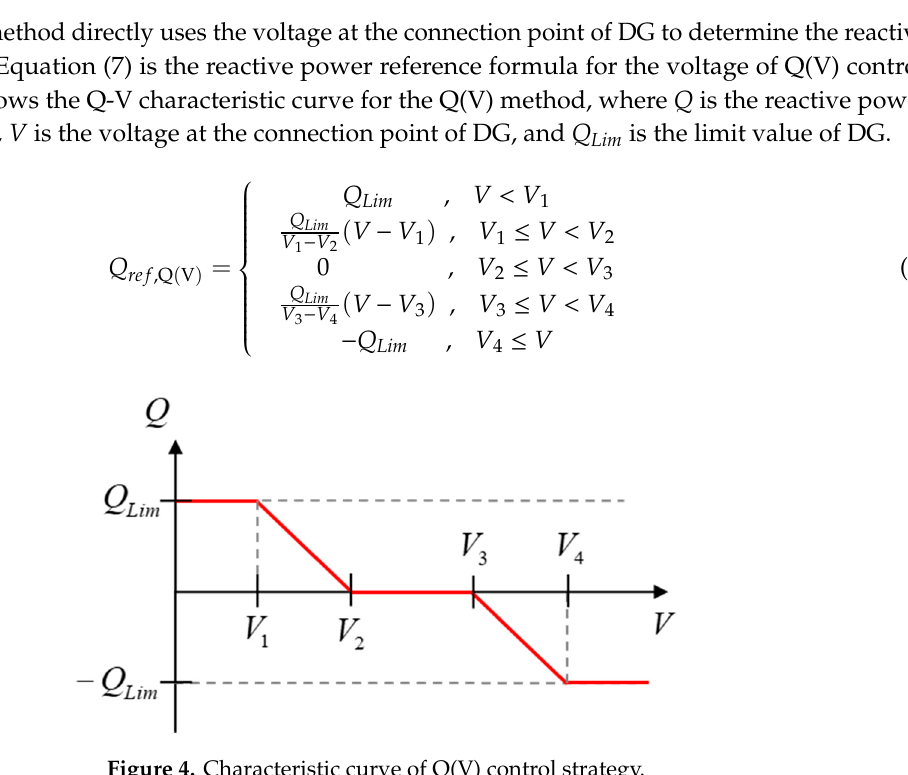
Figure 4. Characteristic curve of Q(V) control Figure 3. Characteristic curve of Q(V) control strategy. Figure 3. Characteristic curve of Q(V) control strategy.